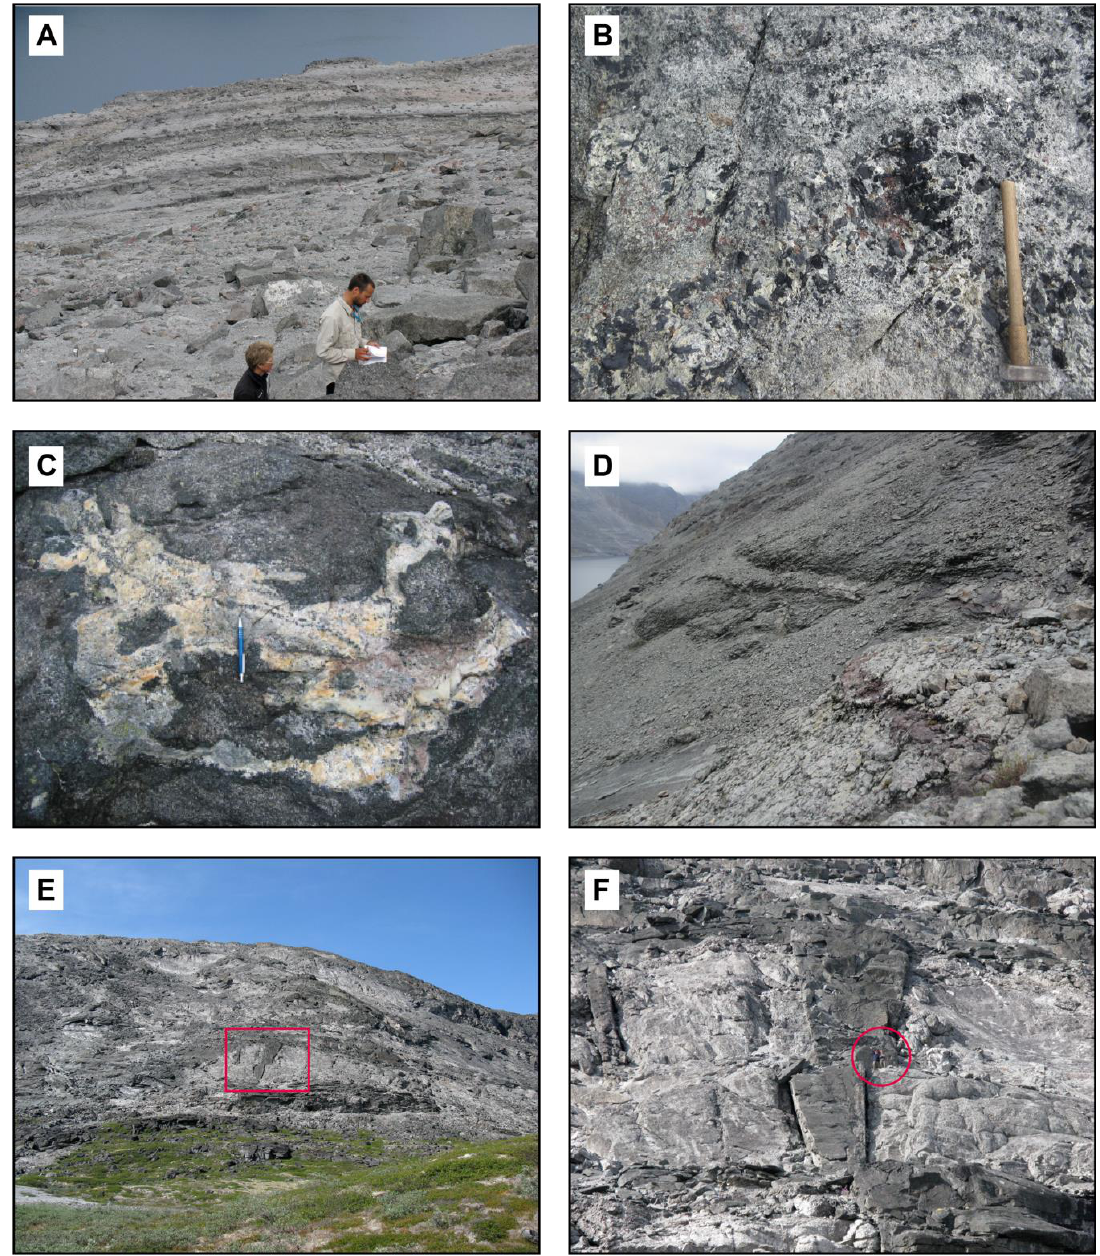
Figure 2. Field aspects of various rocks from the Ilímaussaq Complex, South Greenland. ( A